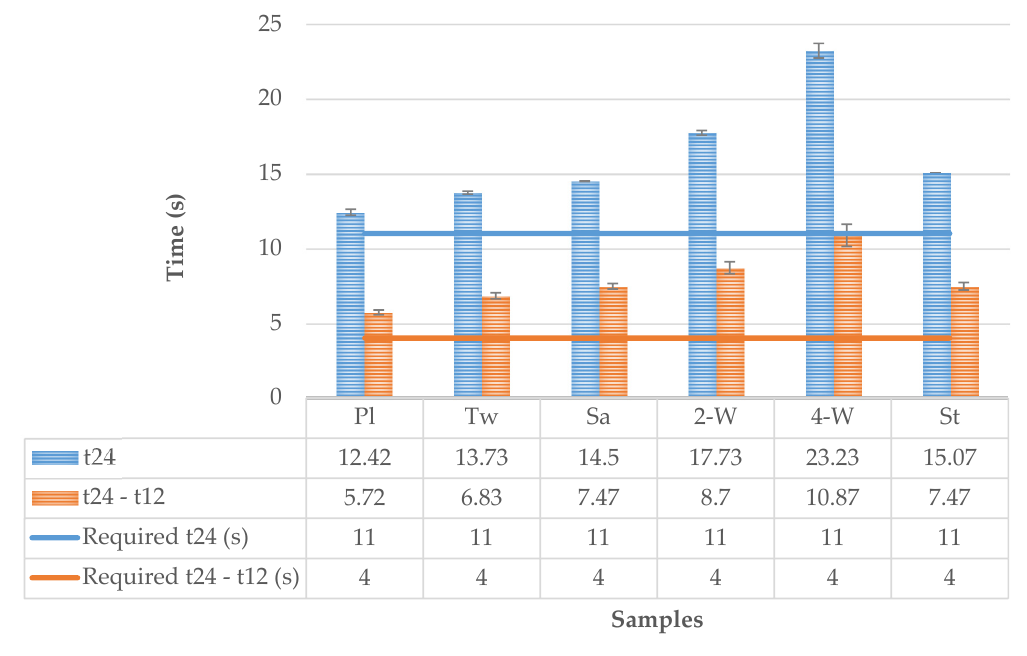
Figure 7. Vapor resistance compared to requirements according to the standard EN 15614 Protective clothing for firefighters requirements for wildland clothing test methods and requirements.